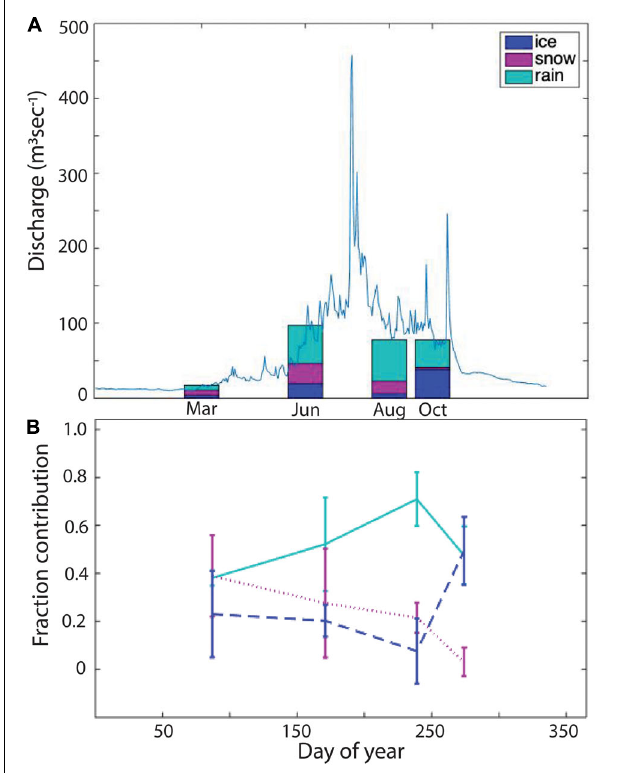
FIGURE 8 | (A) Bayesian Monte Carlo mixing model results of river flow source waters 2016 based on the four sampling campaigns in March, June, August, and October overlaid on the 2016 hydrograph. (B) Fractional contributions and the associated uncertainties of the mixing model solution. Error bars indicate 1 standard deviation.